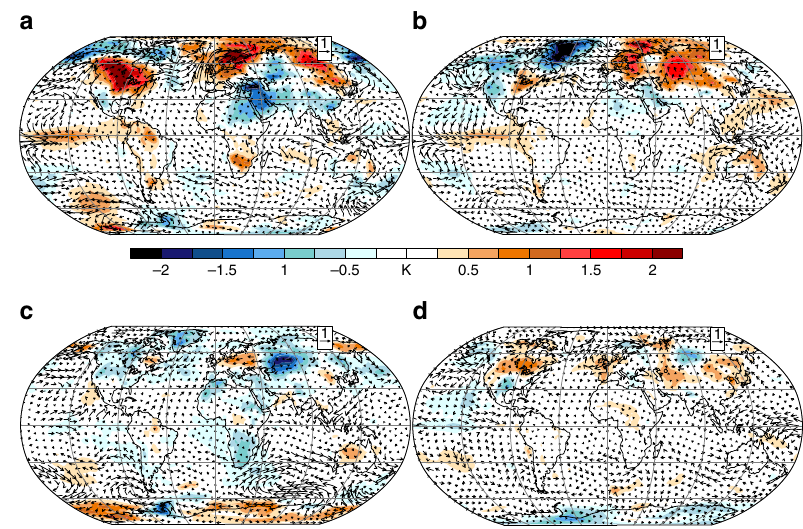
(Fig. 2) and fi nd to be absent from most models. In their analysis, D12 include nine eruptions in total (Table 2), of which fi ve are small eruptions as measured by their stratospheric SO 2 injection ( < 8Tg). An open question is whether the inclusion of the small eruptions in their composite is warranted, due to the potentially minor climate effects of these eruptions, and whether their conclusions regarding model biases are therefore justi fi ed. Here, we conclude that the inclusion of the small eruptions is not warranted as major contrasts are found between composites of the anomalies following the four strong (bold in Table 2) and fi ve weak (italics) eruptions, including the temperature response over North America, Greenland, and central Eurasia. In addition, the strongest eruptions all occurred within 15° of the equator, where Mt. Tambora resides, whereas several of the weaker eruptions occurred outside of the tropics, thereby raising the issue of the response ’ s dependence on latitude 53 – 55 . The need to address volcanic magnitude, latitude, and timing in validating the model response highlighted here is also in agreement with the recent work of others 14,20 . Given these limitations, the extent to which climate models systematically fail to resolve key volcanic responses remains unclear. The NAO reconstruction used for Fig. 2 is from ref. 56 and 2m temperature from ECMWF ’ s ERA Interim reanalysis 57 . Anomaly calculations . The methods used to compute anomalies for 19th and 21st century eruptions differ due to the contrasting nature of available simulations and transient background changes. For the 1815 eruption, unless speci fi ed otherwise anomalies are estimated relative to the 19th century, a period in which transient climate changes remain small relative to the 20th century. In instances where the transient global mean changes of the response are a focus, rather than its spatial structures (e.g., Fig. 2a), anomalies are computed relative to 1814, due to the lingering recovery from the 1809 eruption that would otherwise be con fl ated with that of Mt. Tambora 32 . Of note are recent simulations that quantify contributions of the 1809 eruption and fi nd the effect that persists through 1816 to be that of a cooling that is relatively small and con fi ned mainly to high latitude land regions 32 . In contrast to the anomaly computations for 1815, and as multiple simulations for from the difference of the two sets of simulations and this approach is therefore used. This approach is also necessitated by the large concurrent transient back- ground climate changes under RCP8.5 that accompany the hypothetical future eruption.